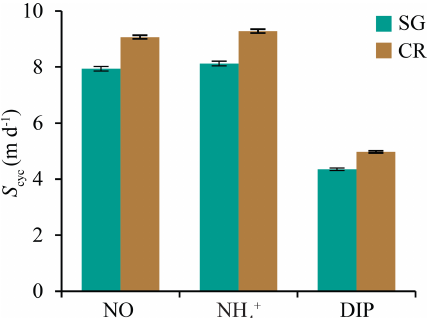
Figure 7. Means ( ± standard deviation) of mass-transfer veloc- ity S for all individual semidiurnal tidal cycles ( n = 23) for ni- trate (NO x ), ammonium (NH + ), and dissolved inorganic phospho- 4 rus (DIP). Values are from SG- and CR-dominated communities.